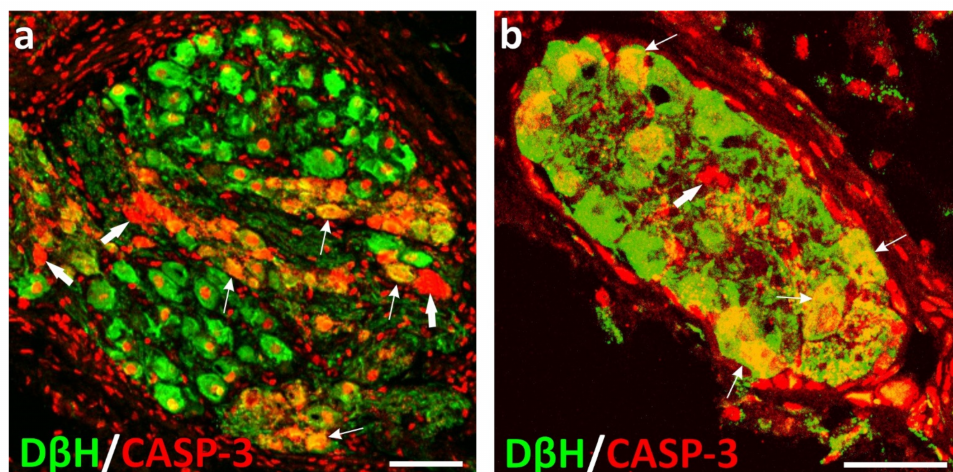
Figure 4. Confocal laser scanning microscope images showing the distribution of CASP-3+ (red; A555) and D β H+ (green; A488) neurons in sections from the APG ( a ) and urinary bladder trigone intramural ganglion ( b ) in the castrated 90-day-old male pigs; GRDS; double-labeled elements are yellow to orange. In the castrated animals, many adrenergic (yellow to orange; some examples are pointed by thin arrows) and some non-adrenergic (cholinergic; red; thick arrows) neurons stained for CASP-3. CASP-3 antibodies unspecifically stained cell nuclei (either neuronal and non-neuronal; information confirmed and provided by the antibody supplier). Bar in image a—100 µ m; Bar in image b—50 µ